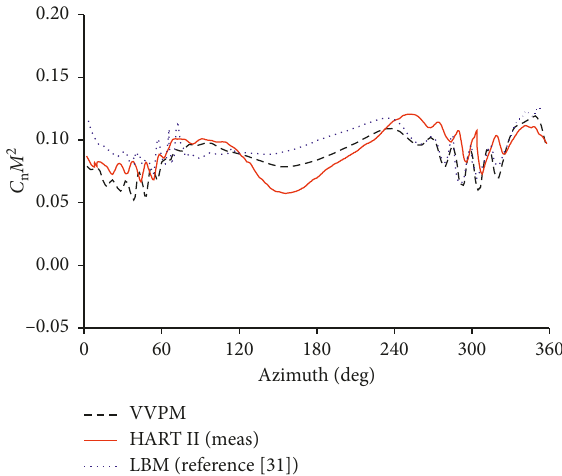
Figure 3: Normal force ( C